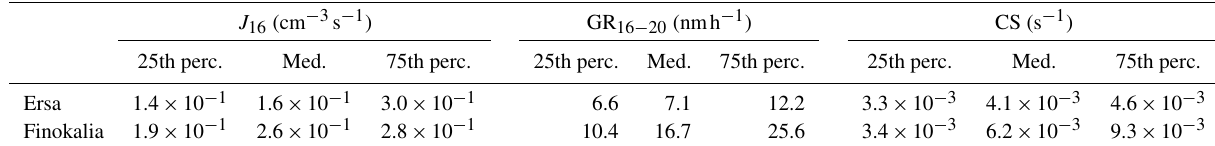
Table 2. Annual median formation rates, growth rates, and annual CS in Ersa and Finokalia. Percentiles are also reported as additional information.